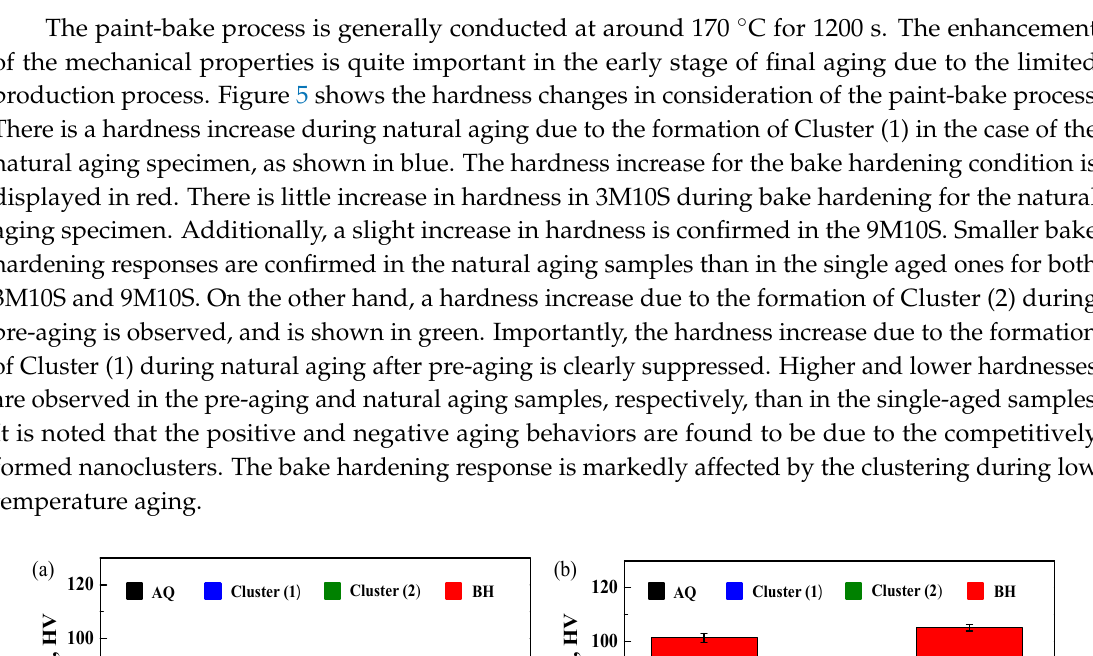
Figure 4. Hardness difference during two-step and multi-step aging at 170 °C in ( a ) 3M10S and ( b ) 9M10S. Hardness difference is defined as the difference value of the obtained hardness during the two-step or multi-step aging at 170 °C from the hardness value at the state of PA-NA or NA. BI, NA, PA and AA stand for before isothermal aging at 170 °C, natural aging for 7 days, presaging at 100 °C, and artificial aging at 170 °C, respectively.